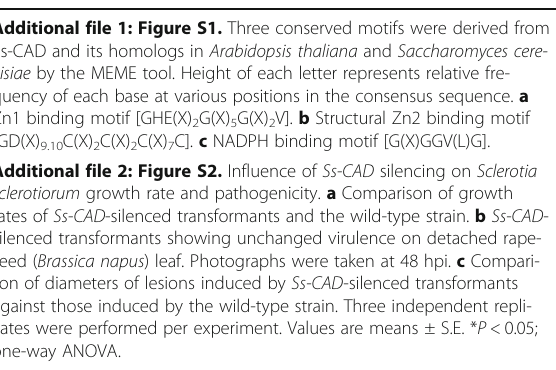
Additional file 3: Table S1. Primers used in the present